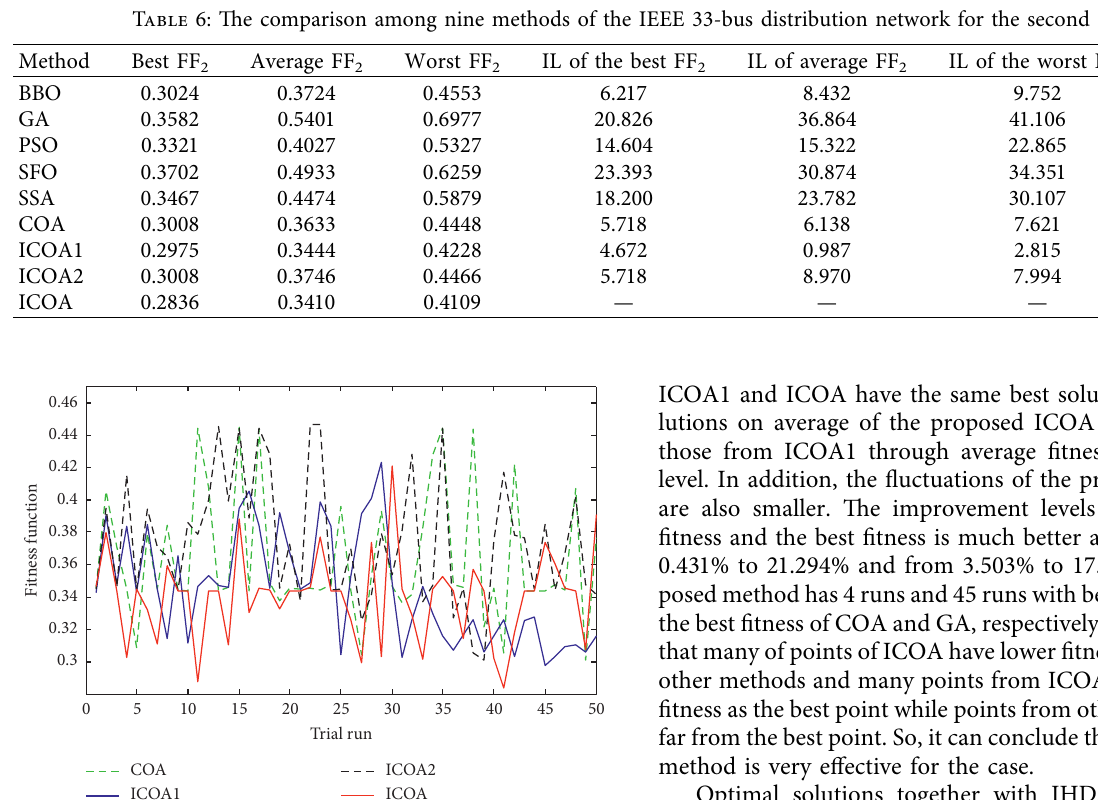
Figure 6: The fitness values of four methods in 50 trial times for the second